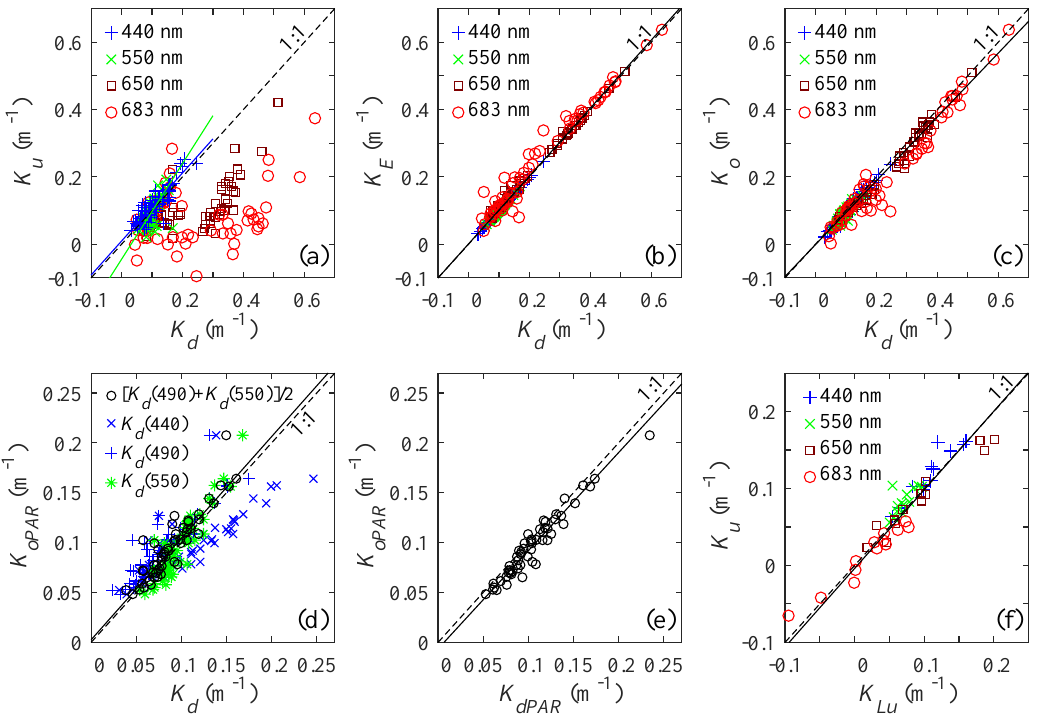
Figure 13. Relationships between diffuse attenuation coefficients based on measurements from all stations and depths. ( a ) K u vs. K d ; ( b ) K E vs. K d ; ( c ) K o vs. K d . ( d ) K dPAR vs. K d ; ( e ) K oPAR vs. K dPAR ; and ( f ) K u vs. K Lu . In ( a – c , f ), different symbols represent data at different light wavelengths as indicated. In ( d ) symbols indicate the relationships between K oPAR ( z ) and different K -coefficients as indicated, including the relationship between K oPAR ( z ) and [ K d ( z , 490) + K d ( z , 550)]/2. The best fit regression functions (solid lines) are shown for ( a ) data at 440 nm and 550 nm analyzed separately, ( b , c ) combined data at 440 nm, 550 nm, and 650 nm, ( d ) data of K oPAR ( z ) vs. [ K d ( z , 490) + K d ( z , 550)]/2, and ( e , f ) all data displayed in these panels. Dashed lines represent the 1:1 agreement between the